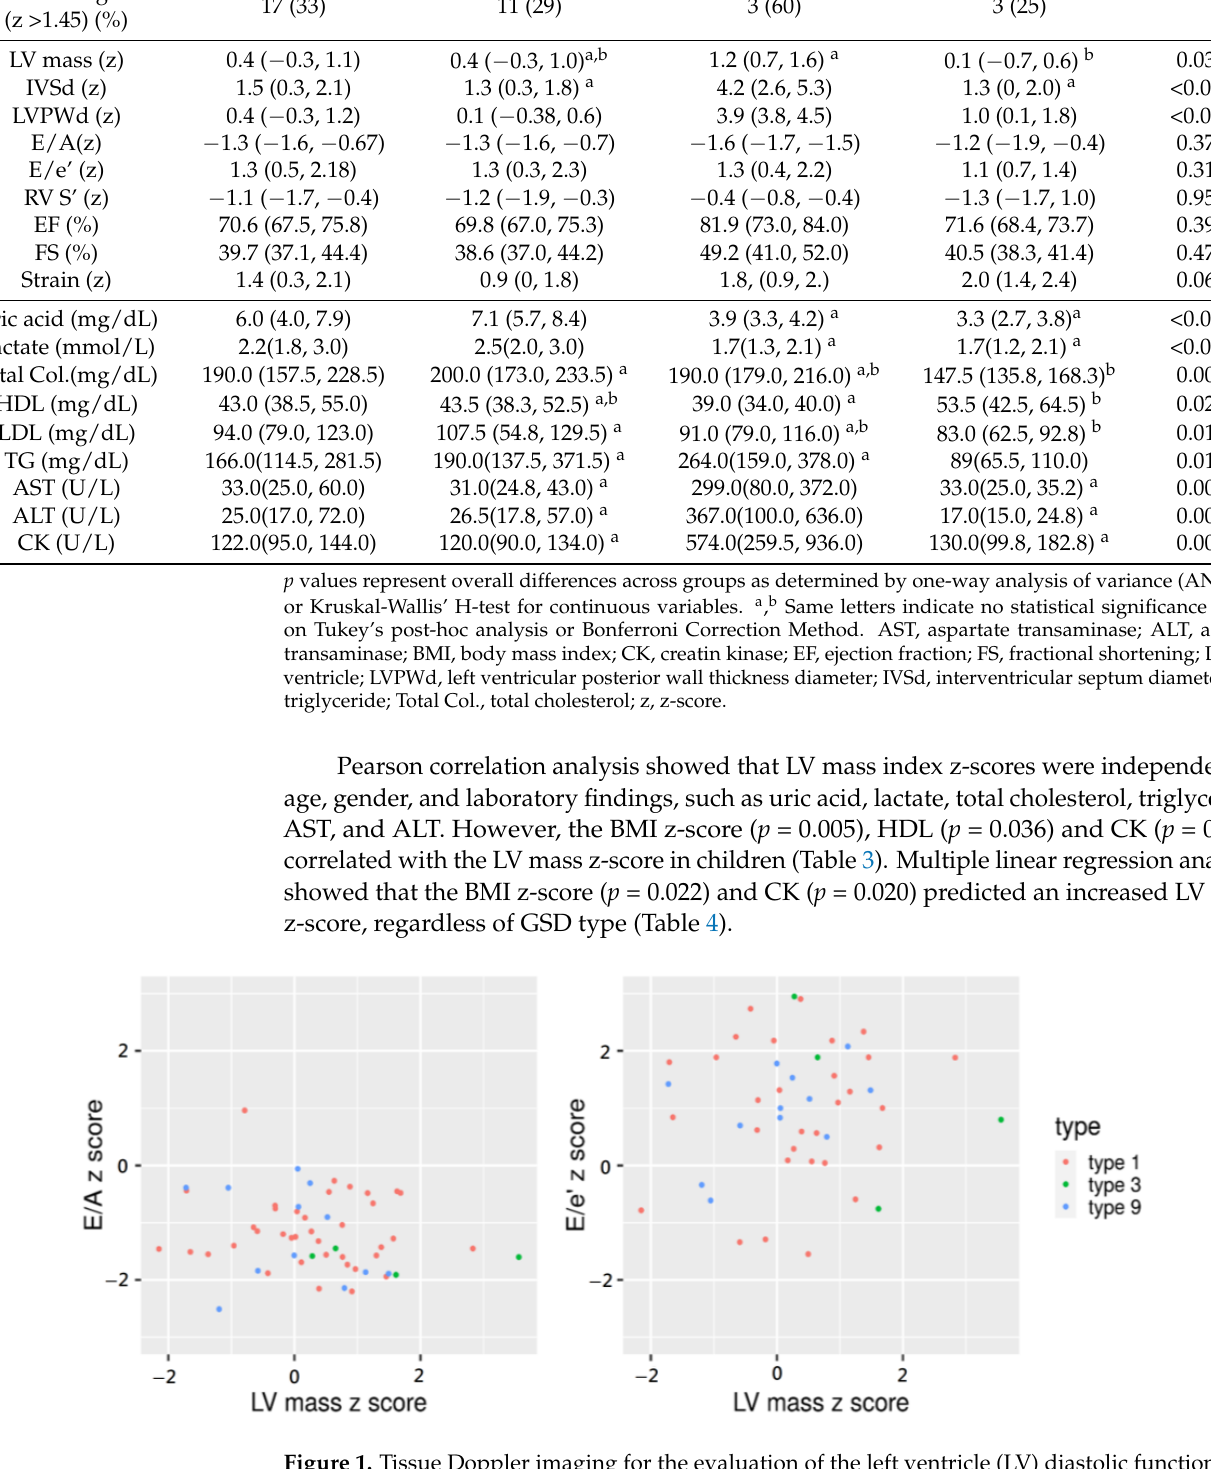
Figure 1. Tissue Doppler imaging for the evaluation of the left ventricle (LV) diastolic function. Pearson correlation analysis showed that LV mass index z-scores were independent of age, gender, and laboratory findings, such as uric acid, lactate, total cholesterol, triglyc- eride, AST, and ALT. However, the BMI z-score ( p = 0.005), HDL ( p = 0.036) and CK ( p = 0.005) correlated with the LV mass z-score in children (Table 3). Multiple linear regression analysis showed that the BMI z-score ( p = 0.022) and CK ( p = 0.020) predicted an increased LV mass z-score, regardless of GSD type (Table 4). Table 3. Correlation analysis of risk factors for LV mass z score in child age. Variables